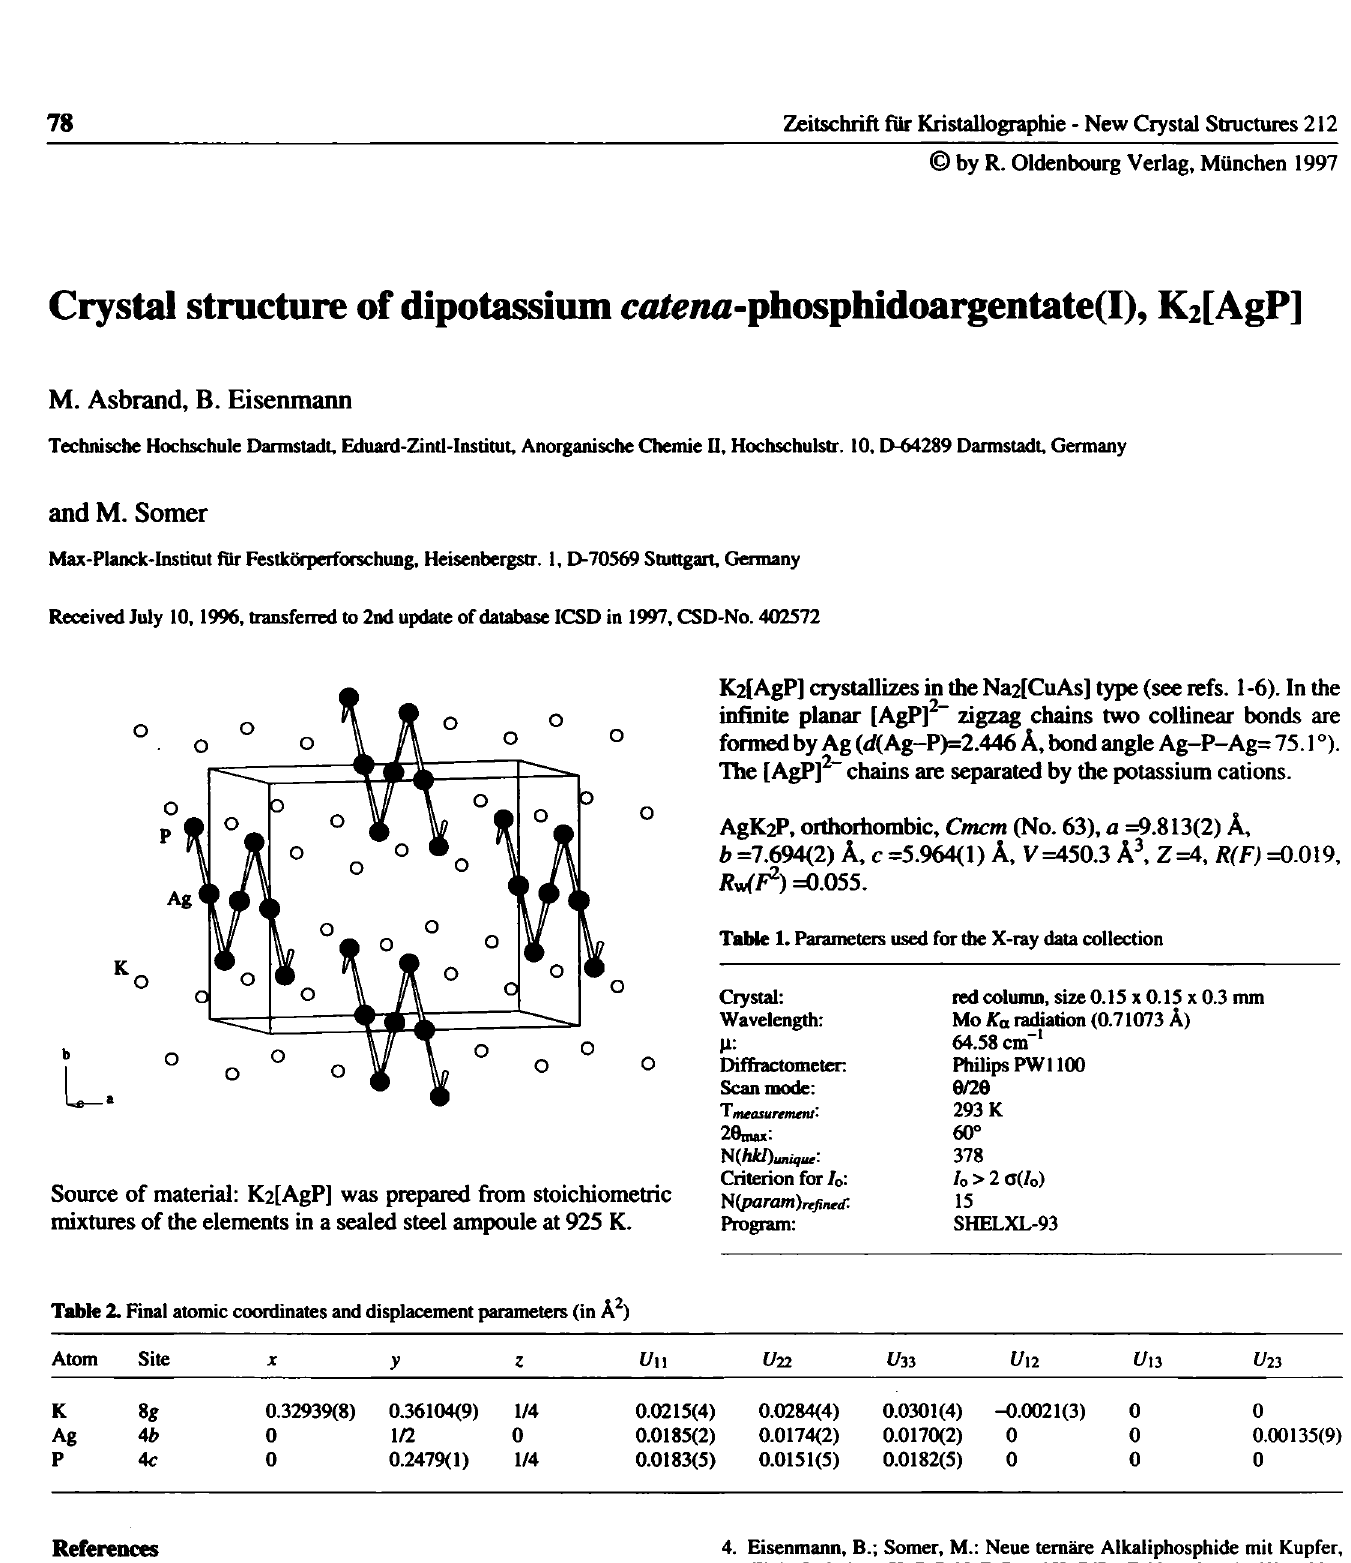
Table 2. Final atomic coordinates and displacement parameters (in Â 2